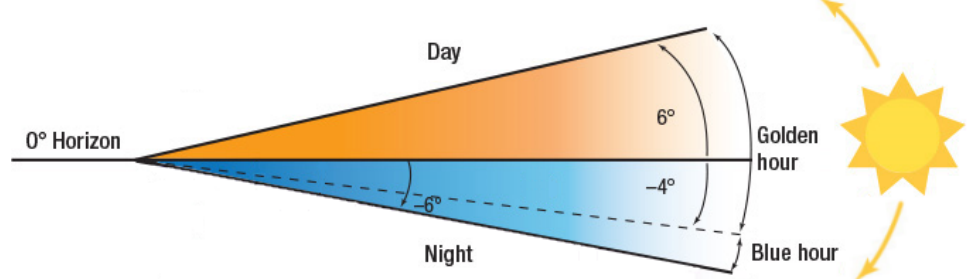
Figure 6. Solar altitude between Sun and local